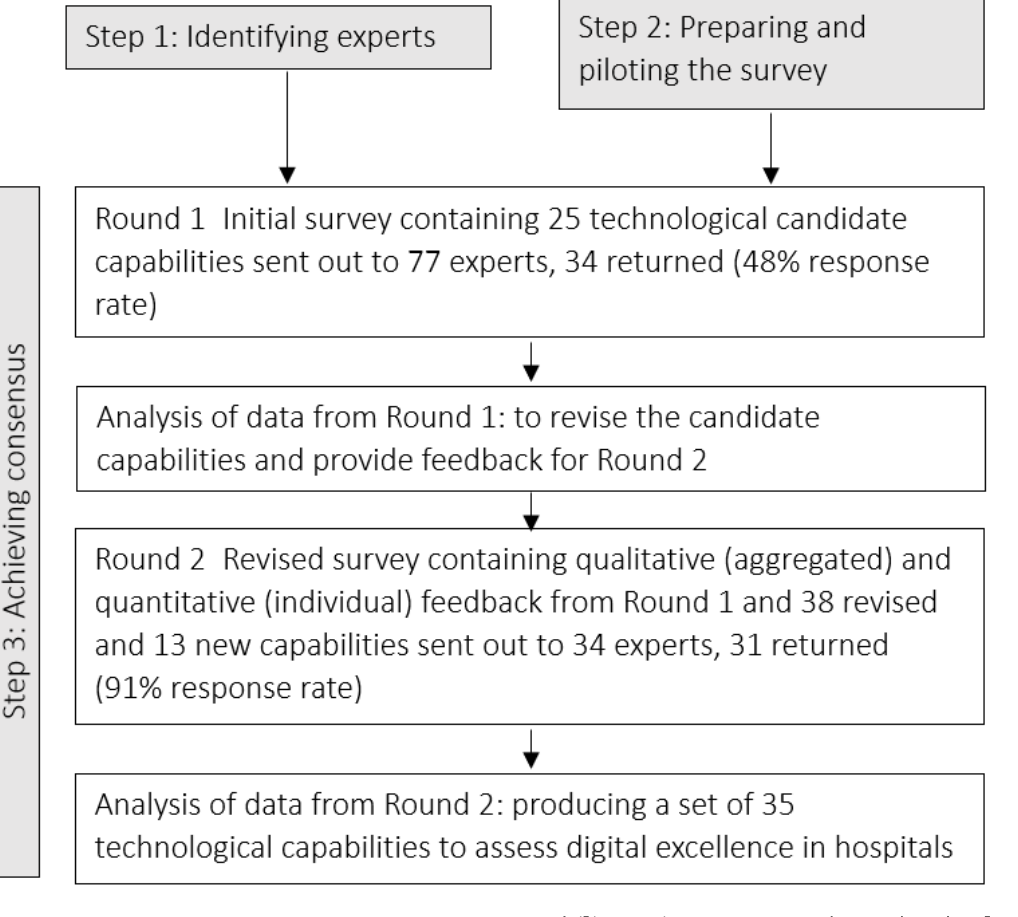
Figure 1. Flow diagram for the eDelphi